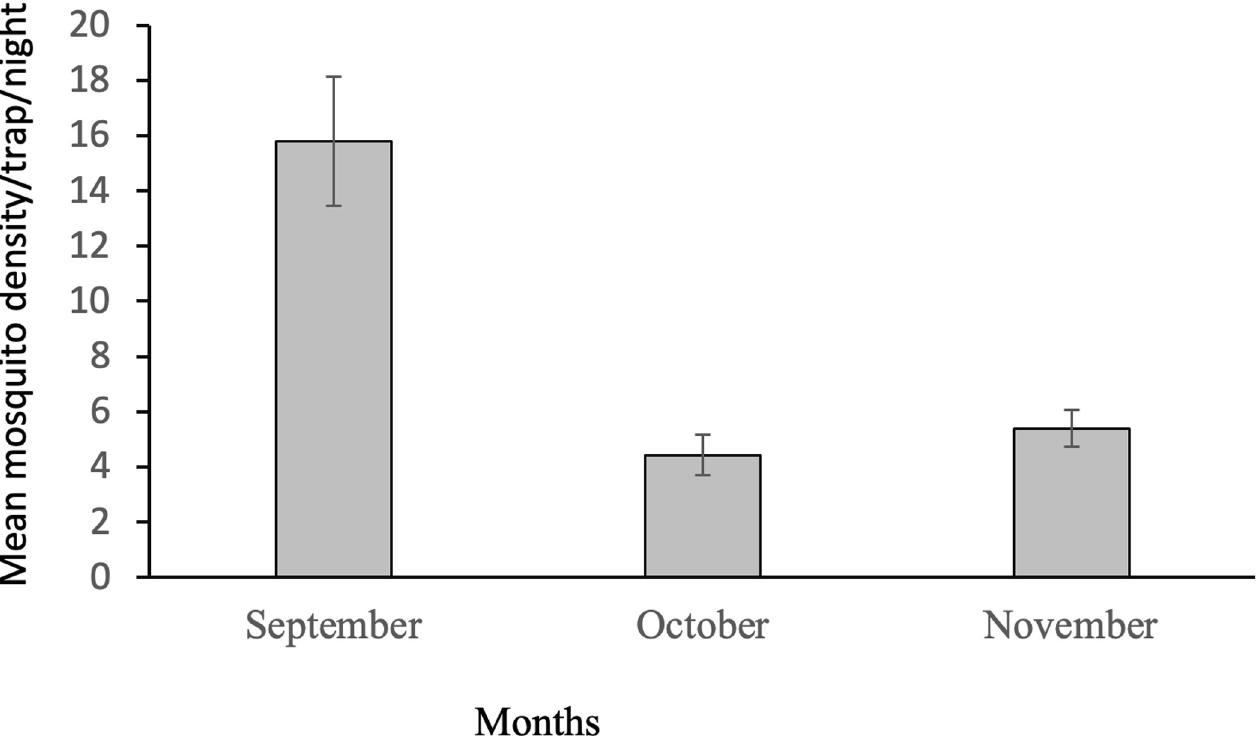
Fig 5. Density of mosquitoes collected in different months in all